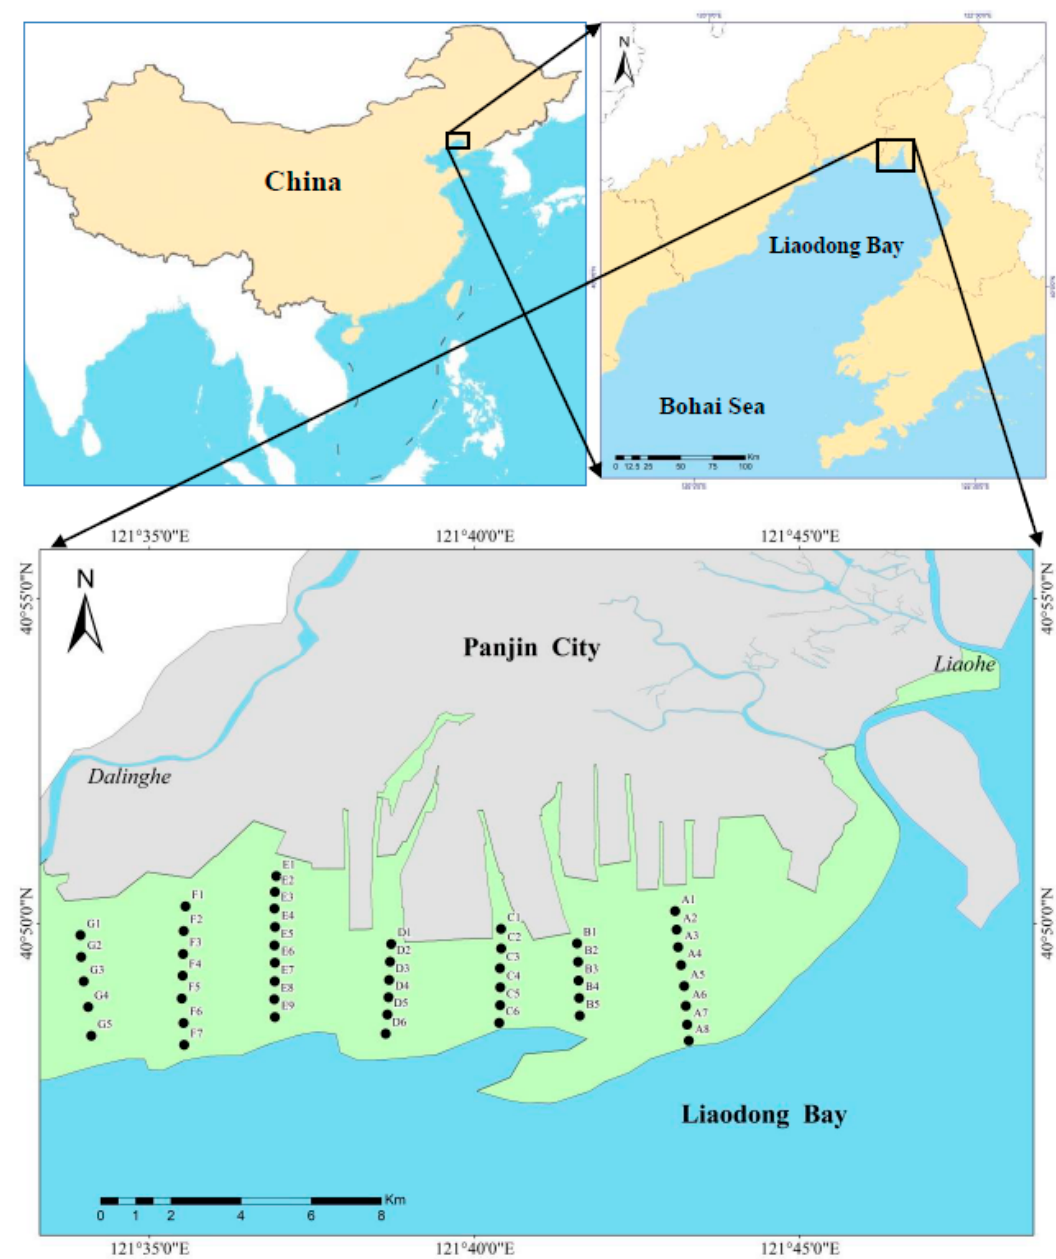
Figure 1. Sampling sites for macrobenthos and sediments in the intertidal flat of Liaohe Estuary. Note: grey indicates areas of the land and mariculture pond; green indicates the tidal flats areas; and blue indicates the rivers and sea areas.